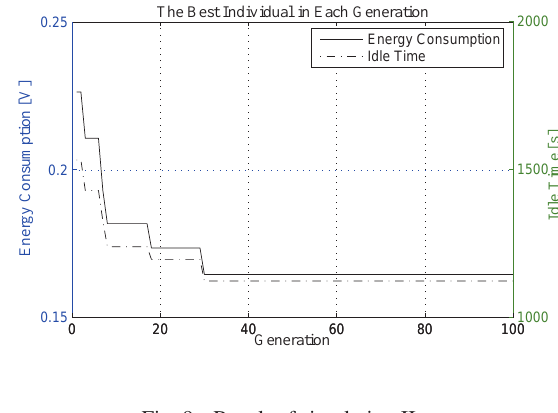
Fig. 9. Result of simulation II.